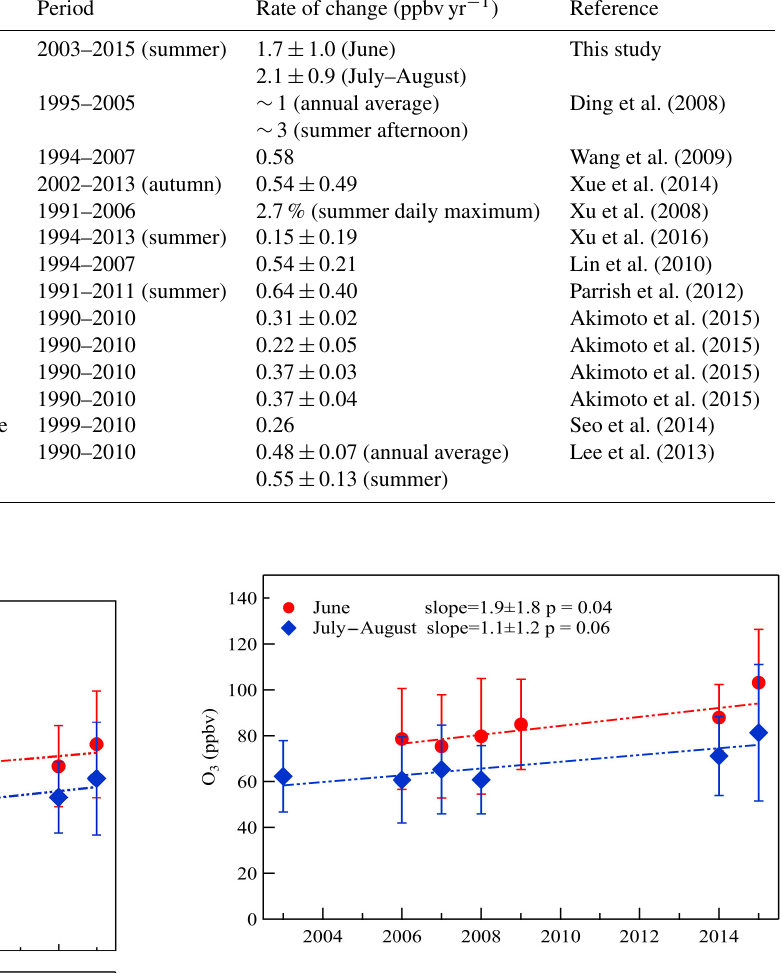
Figure 7. Monthly averaged nighttime O 3 mixing ratios (inferring the regional background O 3 ) at Mt. Tai in June and July–August over 2003–2015. Error bars indicate the standard deviation of the mean. The fitted lines are derived from the least square linear re- gression analysis with the slopes ( ± 95% confidence intervals) and p values